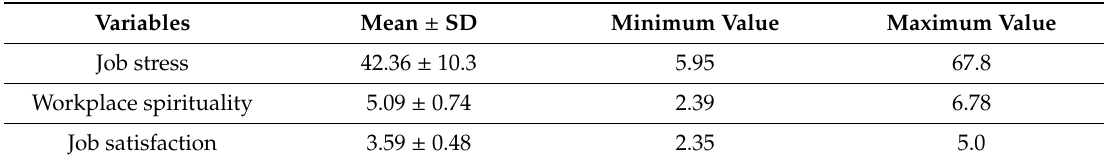
Table 2. Job stress, workplace spirituality, and job satisfaction of participants ( N = 126).